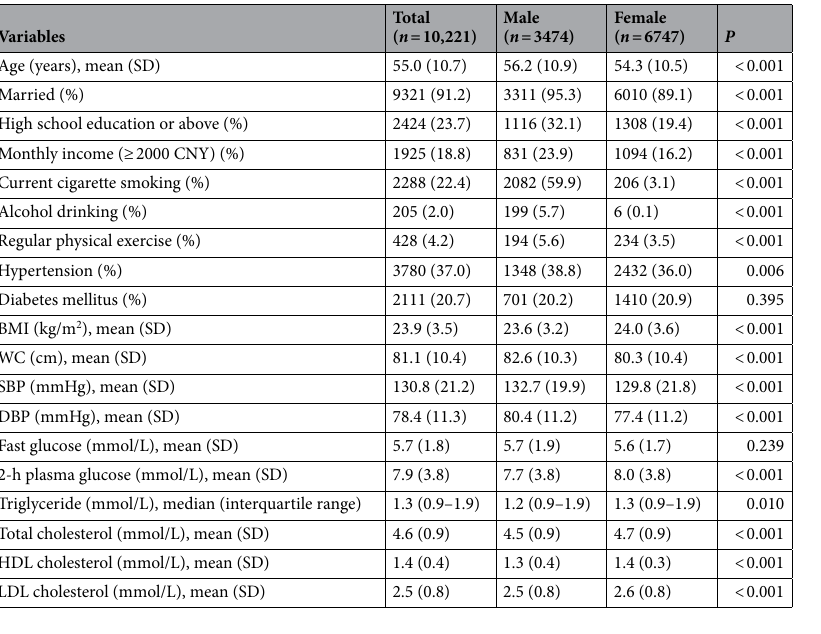
Table 1. Demographic and clinical characteristics of study participants. BMI, body mass index; WC, waist circumference; SBP, systolic blood pressure; DBP, diastolic blood